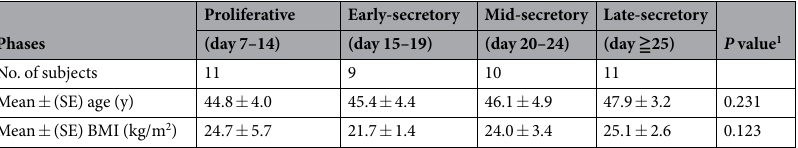
Table 1. Demographic data of the subjects at different phases of the menstrual cycle. 1 p value was K-W test between four phases in leiomyoma. No significant differences were observed between the groups (P >